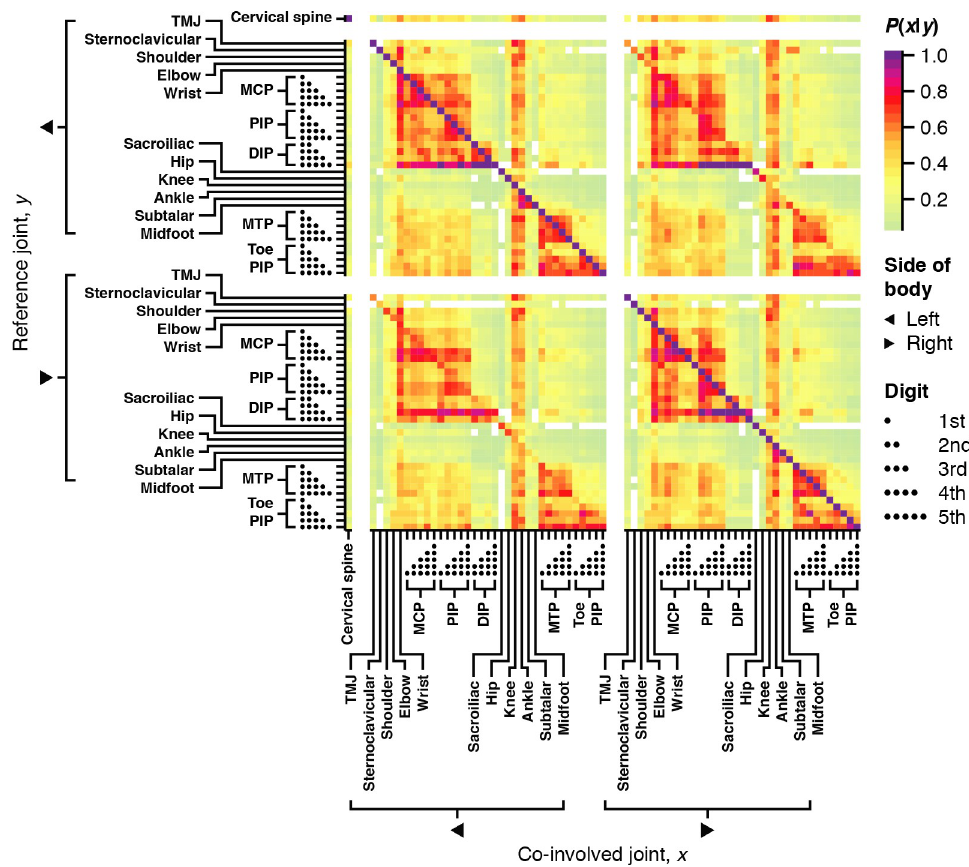
Fig 2. Logical groupings of joints were co-involved. Heat map of conditional probabilities of involvement, P ( x | y ) (colors; right upper legend), of co-involved joints x (x-axis) given reference joints y (y-axis). White denotes zero. Arrows represent side of body (right middle legend), and the number of dots represents finger or toe number (right lower legend). DIP, distal interphalangeal; MCP, metacarpophalangeal; PIP, proximal interphalangeal; TMJ, temporomandibular